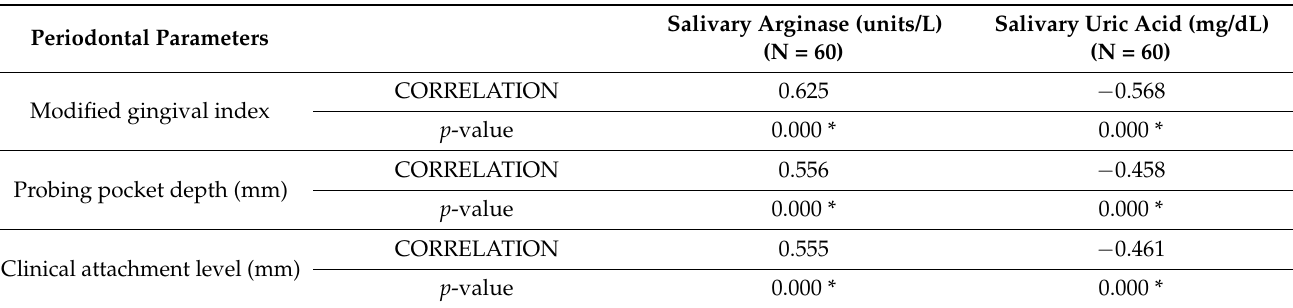
Table 3. Karl Pearson correlation analysis of salivary arginase and uric acid levels and all periodontal parameters on day 0for all three groups (I, II, and III).